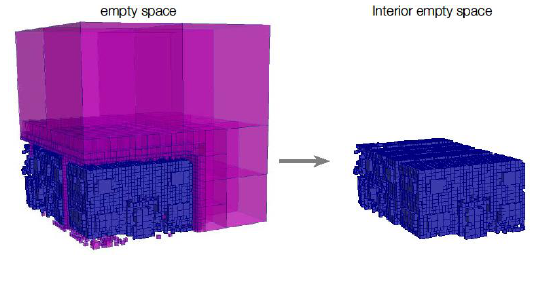
Figure 12: Filtering of interior empty